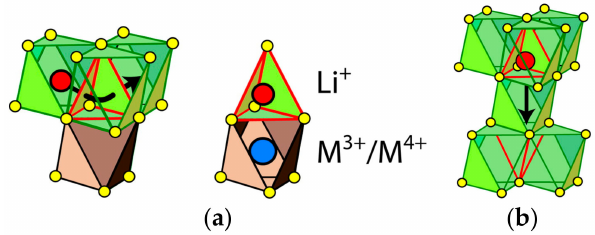
Figure 6. Illustrations of Li hoping route in: layered oxides ( a ); and spinel oxides ( b ) (Reproduced with permission from [49], Copyright 2013, American Chemical